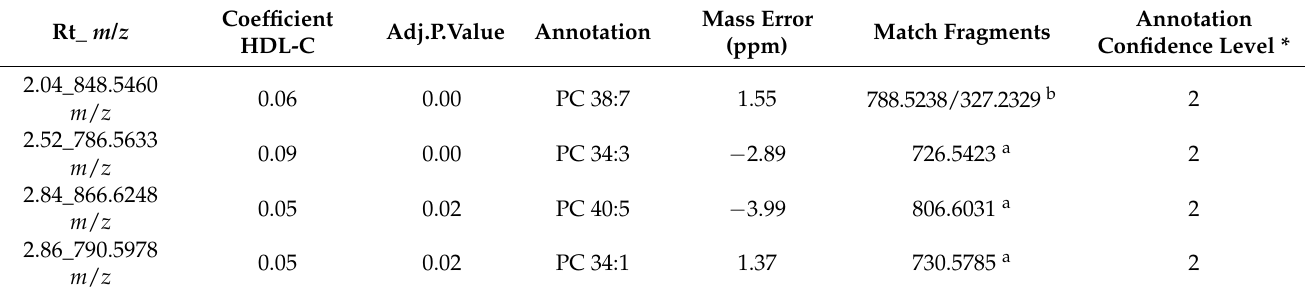
Table 3. MS-annotated lipids with statistically significant associations with HDL-C serum levels.